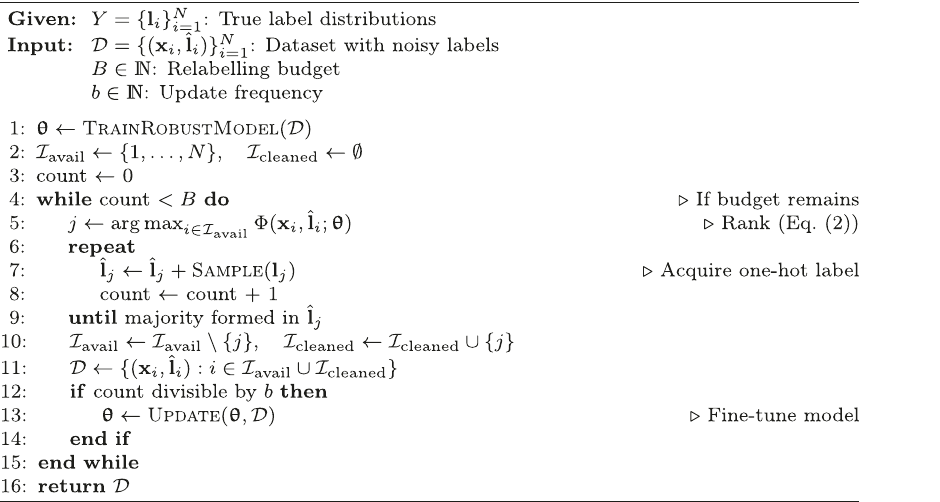
Algorithm 1 . Active label